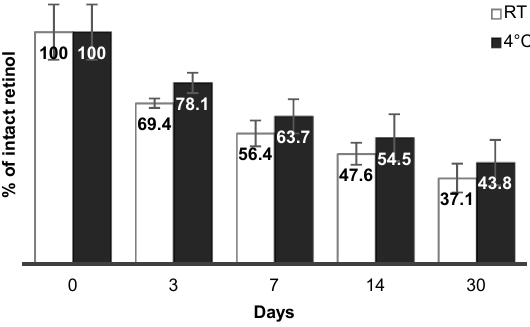
Figure 8. Chemical stability at room temperature (white) and 4 °C (black) of retinol incorporated into nanocarriers.